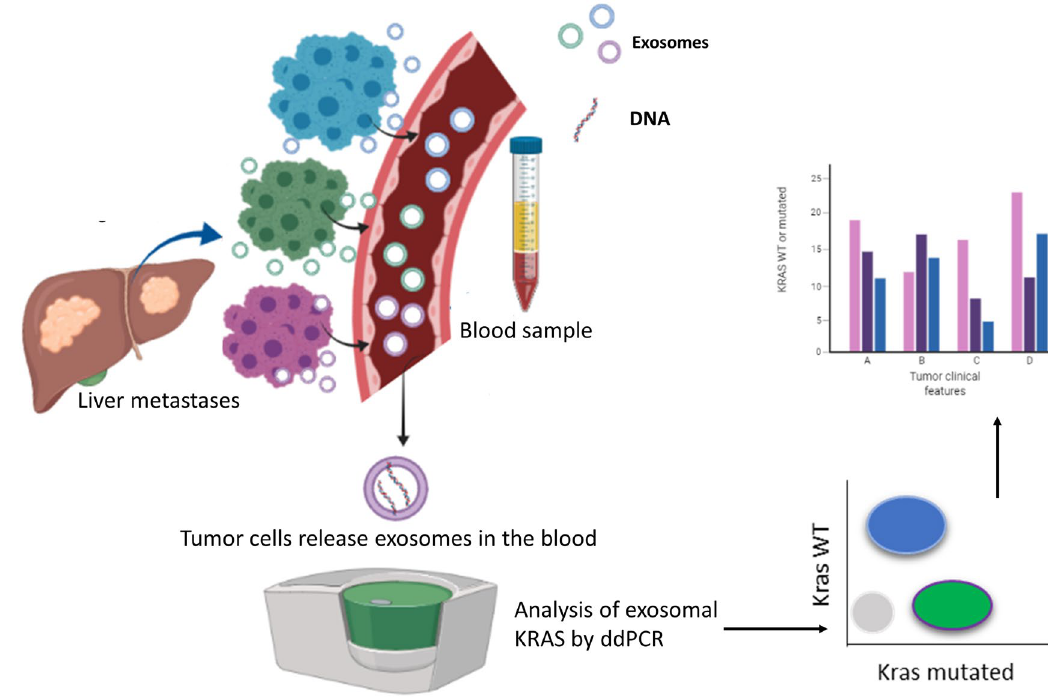
Figure 4. Scheme of exosome-based liquid biopsy (created with